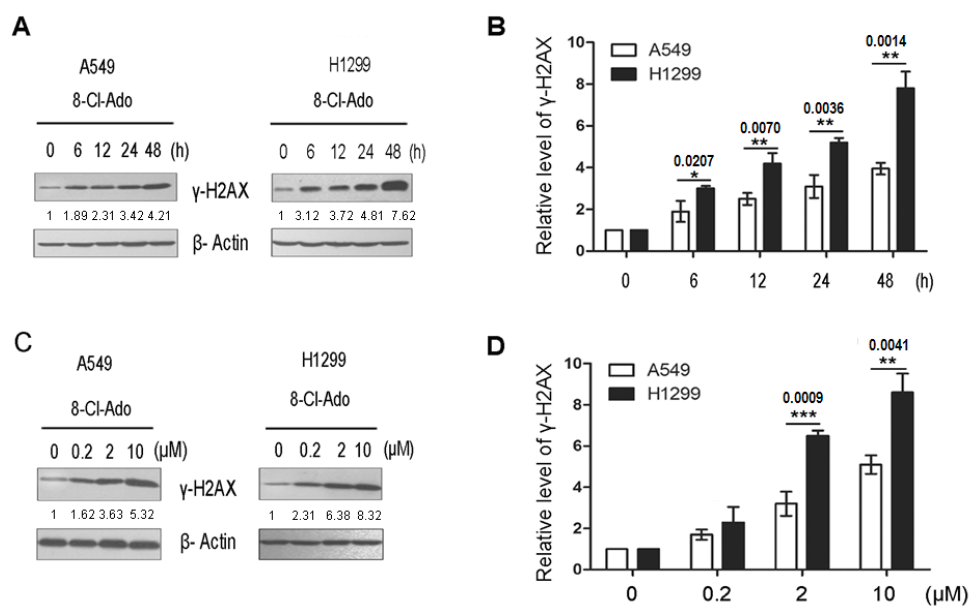
Figure 4. Western blotting and immunocytochemistry for γ -H2AX expression in A549 and H1299 cells. ( A ) Cells were exposed to 2 μ M 8-Cl-Ado for 0, 6, 12, 24 and 48 h. Western blotting was performed with specific antibody. β -Actin as a loading control; ( B ) histograms showing the relative levels of γ -H2AX in ( A ) experiments. The ratio of γ -H2AX to Actin at 0 h is normalized to “1”. Data represent mean ± SD ( n = 3); ( C ) cells were exposed to 8-Cl-Ado at the indicated concentrations for 48 h, and Western blotting was performed for a dose-dependent increase of γ -H2AX; ( D ) histograms showing the relative levels of γ -H2AX in ( C ) experiments. * p < 0.05; ** p < 0.01; *** p < 0.001.